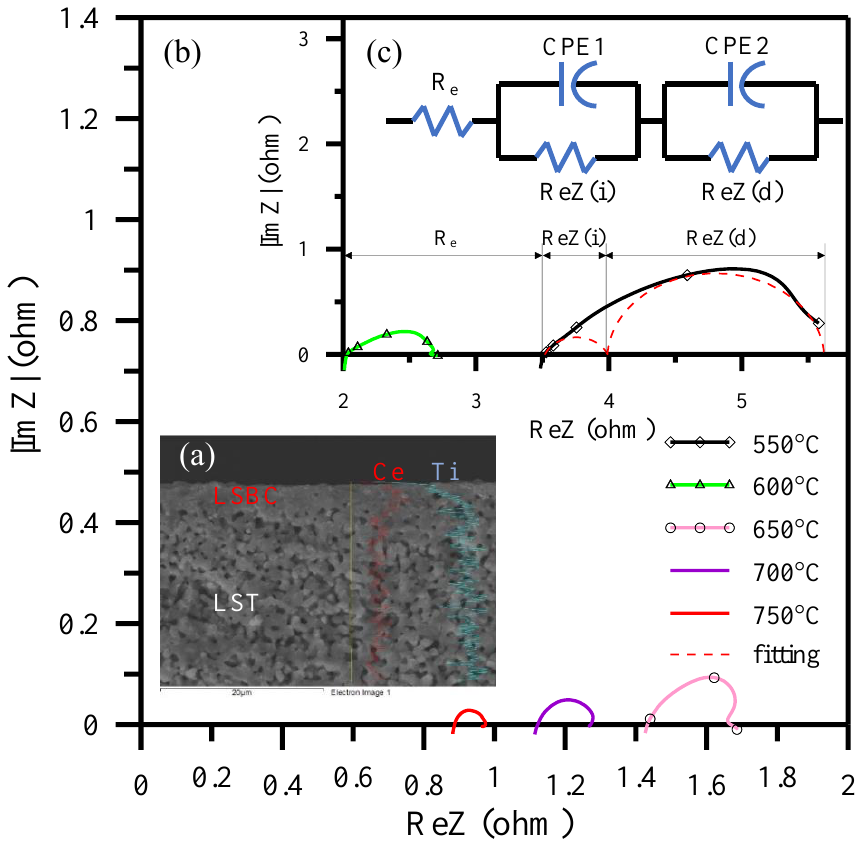
Figure 14. Co-fired iLSBC/LST half-cell prepared by ultrasonic spray pyrolysis and measured at a temperature of 550 – 750 °C for ( a ) FESEM cross-section of iLSBC/LST with line scanning marking Ce (red color) and Ti (light blue color) elements, AC impedances among ( b ) 650 – 750 °C and ( c ) 550 – 600 °C and RQ fitting for 550 °C.